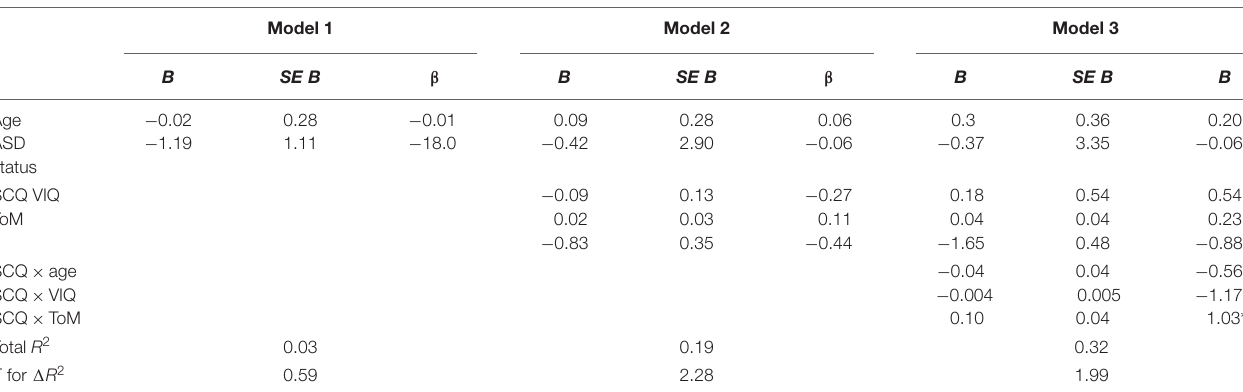
TABLE 4 | Hierarchical multiple regression predicting imaginary objects subtype of pretend